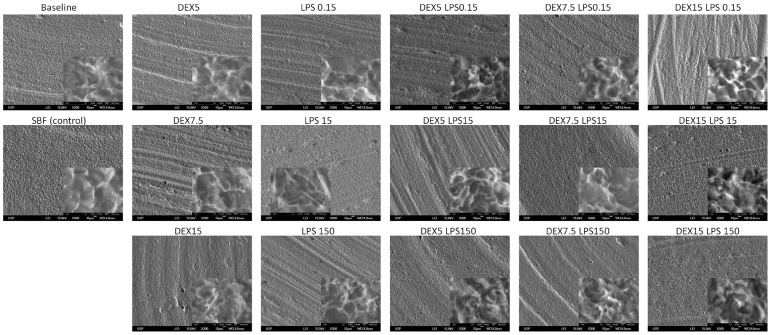
Scanning electron microscope images (300× and 10,000×) of the Ti-6Al-4V alloy with acid-etched surface,showing the Ti-6Al-4V alloy surface before and after corrosion in SBF (control - Co) with different concentrations of dextrose (DEX) and lipopolysaccharide (LPS), alone or in combination (DEXLPS). WD  =  8 mm; 15 Kv.